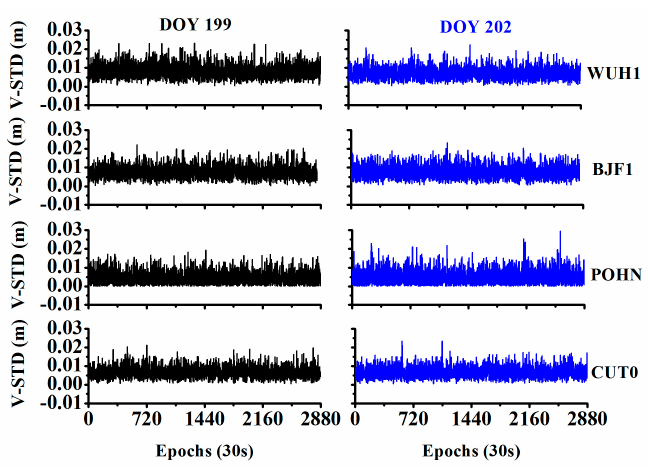
Figure 6. STD time series of the observation residuals for different stations and different days.